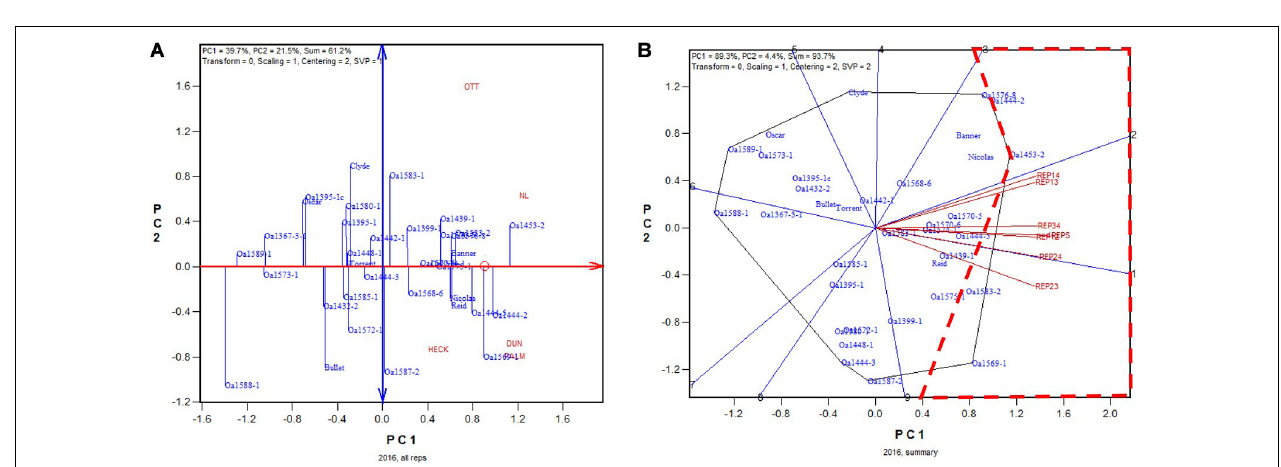
FIGURE 4 | Biplots for the 2015 Ontario trials. (A) GGE biplot to show genotype ranking based on data from all four replicates, and (B) summary biplot to show the genotype rankings based on all four replicates and on any two of them. 4REPS, genotypic ranking based on all four replicates; REP12, genotypic ranking based on replicates 1 and 2; REP13, genotypic ranking based on replicates 1 and 3, and so on.